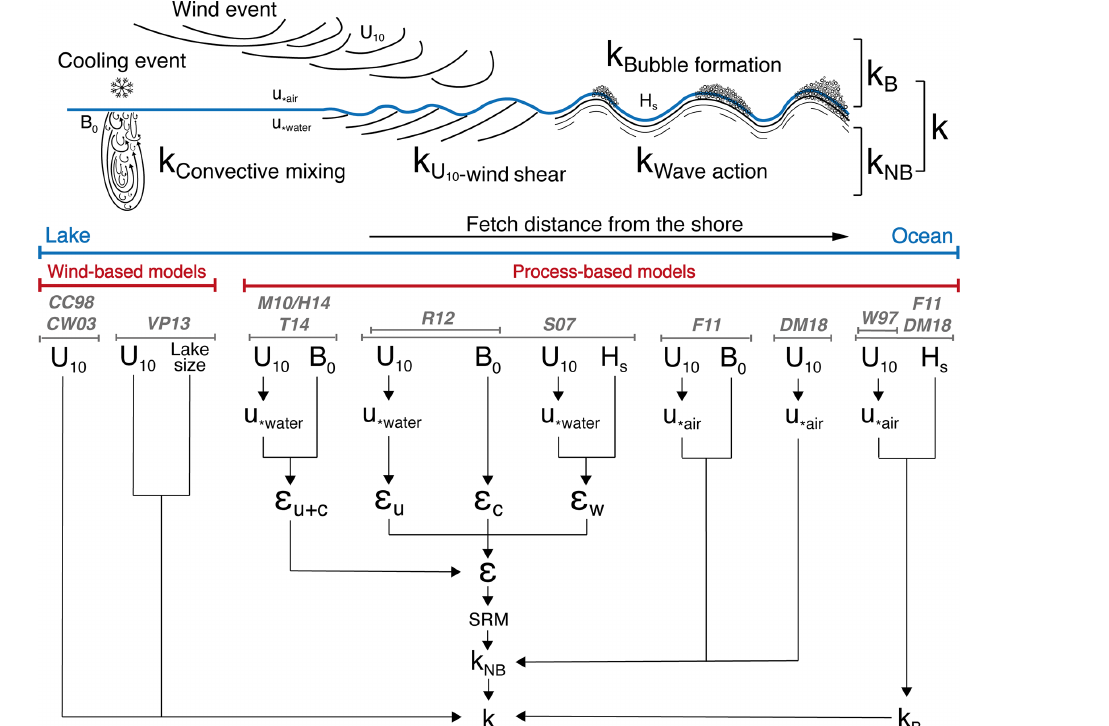
Figure 1. Conceptual scheme of the four main processes driving gas transfer velocity ( k ) in a large lake induced by wind and cooling events. These four processes are split into two types of k : k -bubble for the bubble formation ( k B = k b ) and k -no bubble for the convective mixing, wind shear, and wave action term which are added ( k NB = k c + k u + k w ). Below this scheme, a non-exhaustive review of the conceptual approaches of k models used in first Fickian law is given. From left to right, the increase in the complexity level of k models and their study site (limnological to oceanic case) is visible. All of these variables are described in Sect. 2.4 and Table